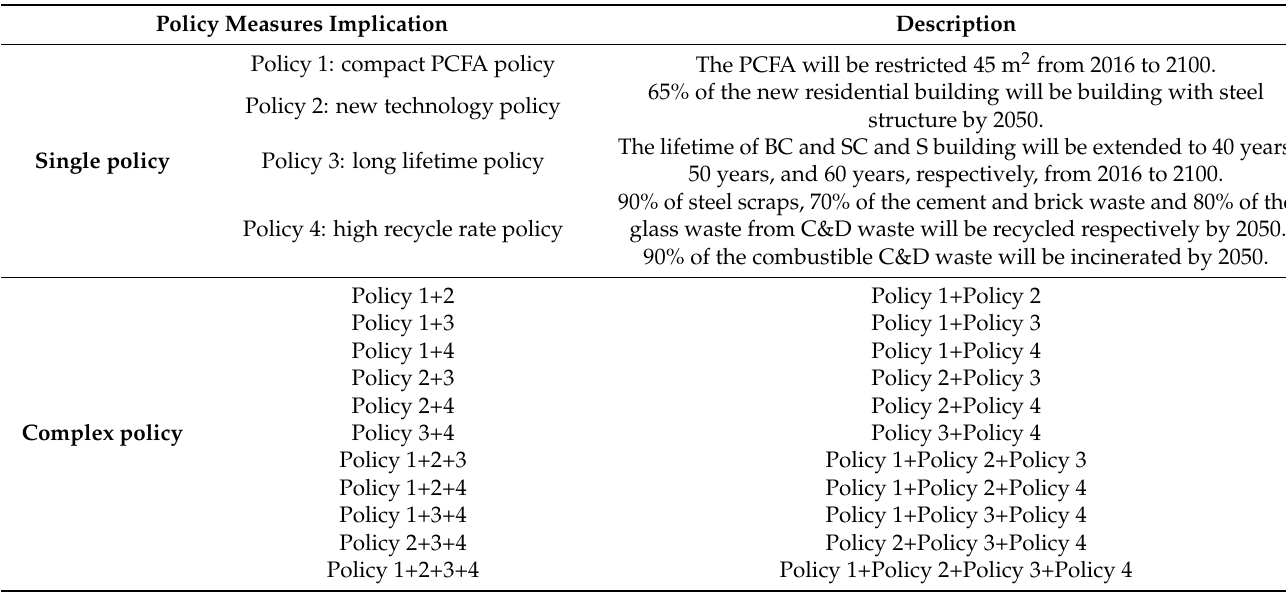
Table 5. The proposed policy